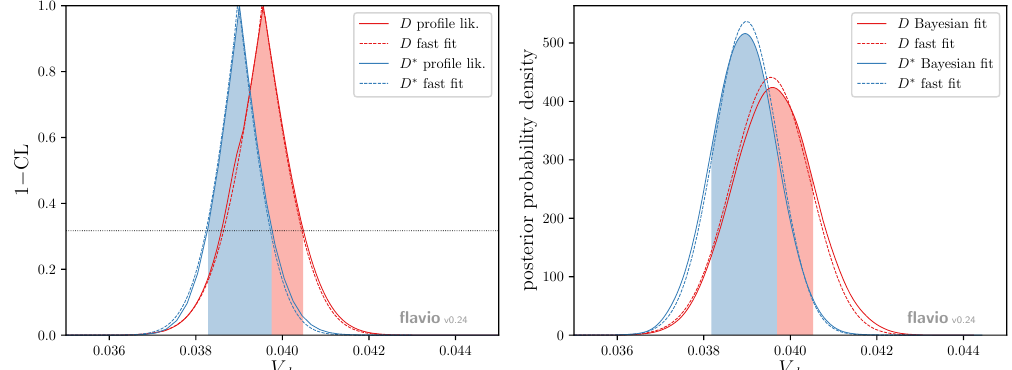
Figure 1 . Fit results for V cb from exclusive decays in the Standard Model. Left: frequentist pro(cid:12)le likelihood vs. \fast (cid:12)t" method; the horizontal dotted line delineates the 1 (cid:27) region. Right: Bayesian posterior probability vs. \fast (cid:12)t"